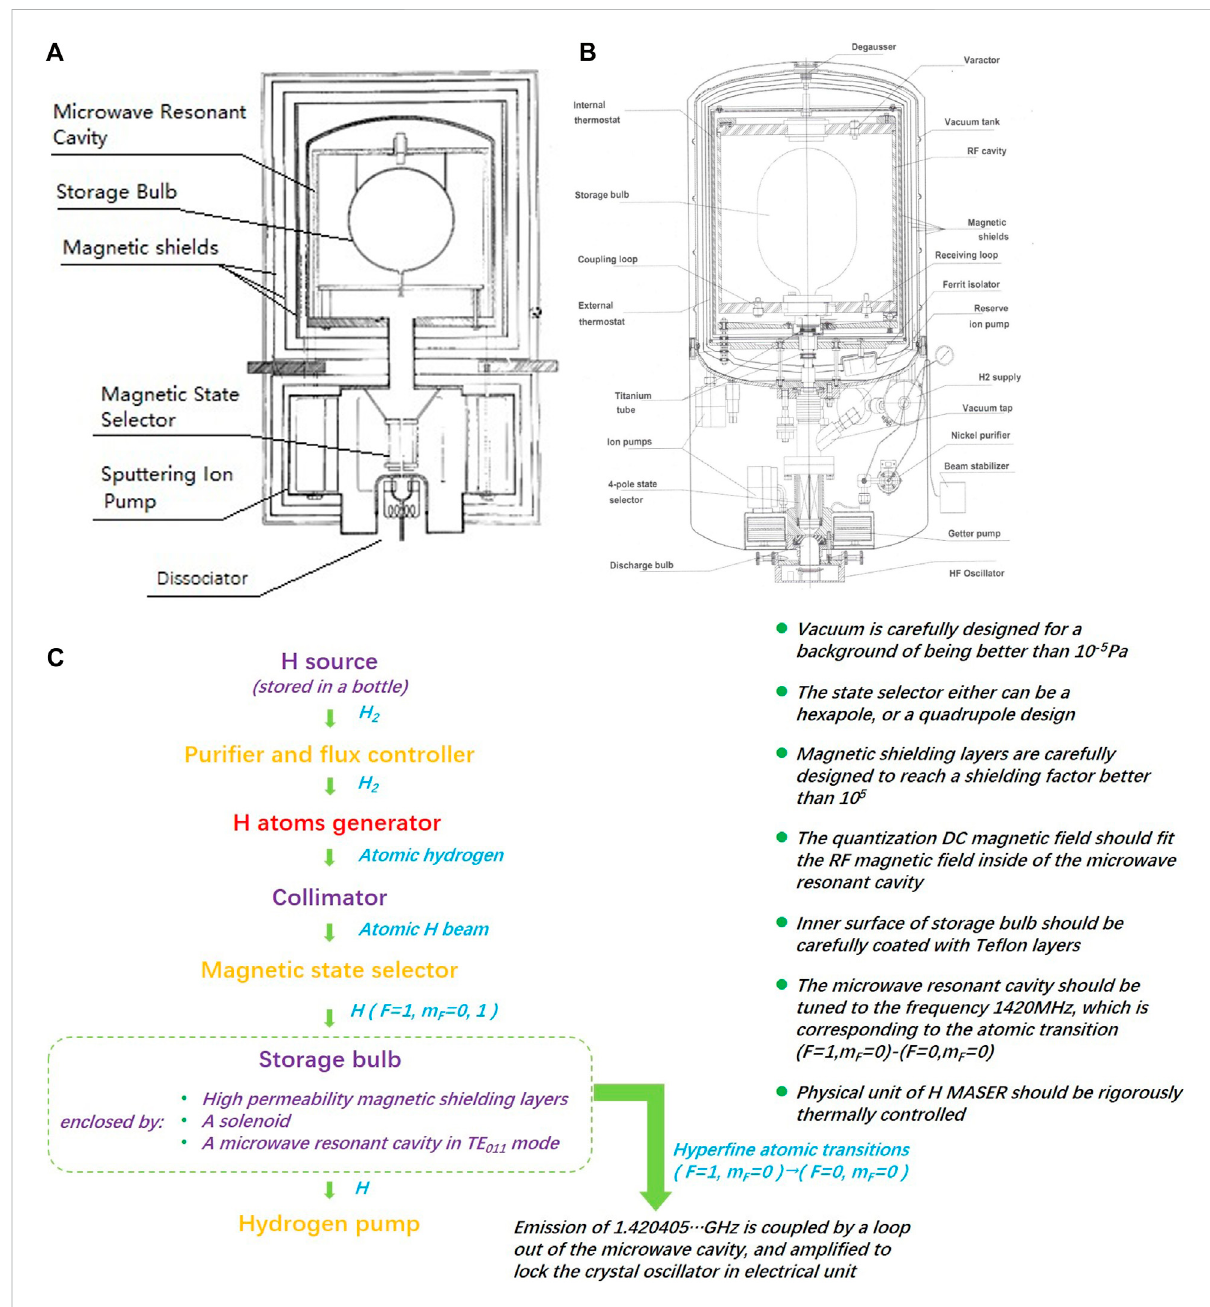
FIGURE 3 Schematic diagram of the standard active H-maser. (A) An H-maser unit for a satellite experiment in the 1960s; (B) a VCH 1003M unit; (C) summary of the standard H-maser